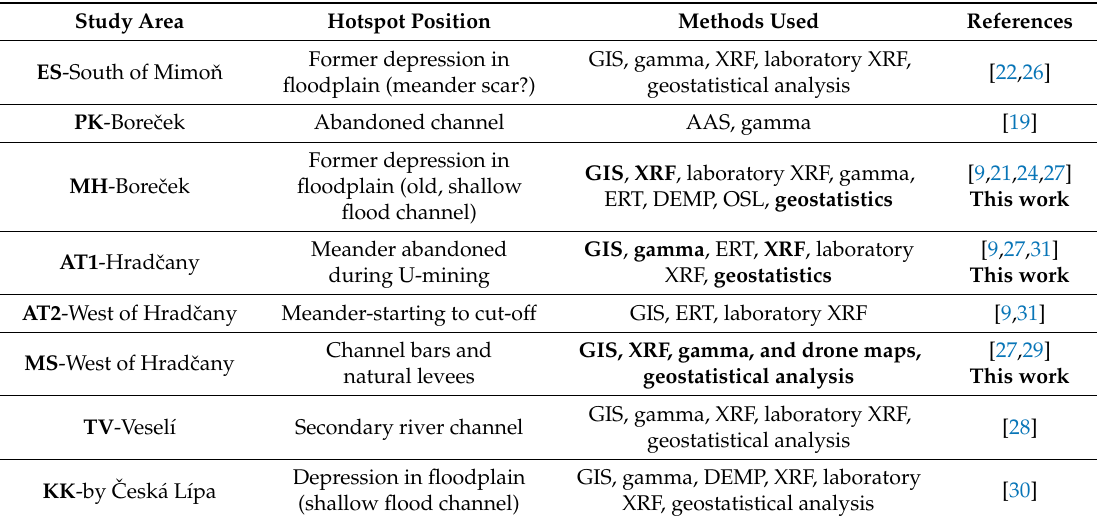
Table 2. Overview of polluted hotspots ordered in a downstream direction. Methods used in this work are in